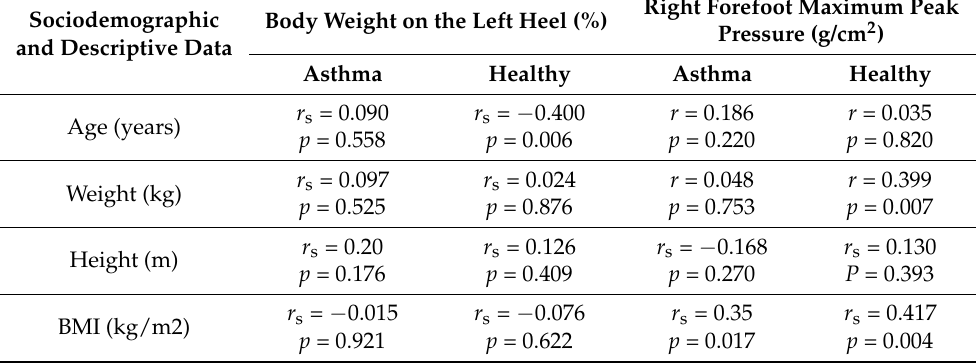
Table 3. Bivariate correlational analyses for patients diagnosed with asthma and healthy matched- paired controls.